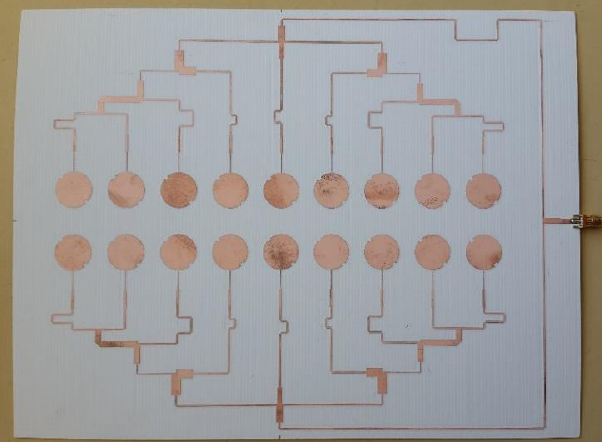
Figure 10. Photograph of the antenna array.